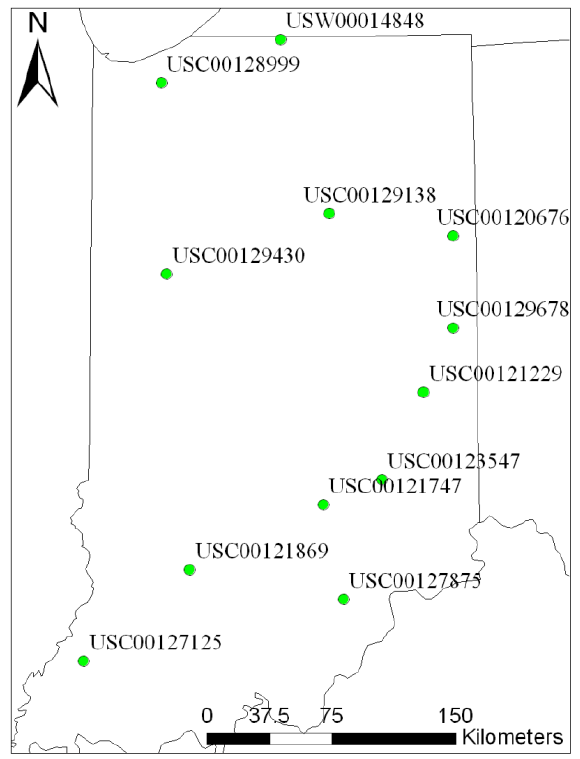
Figure 1. Location Map of NCDC and CLIGEN stations within